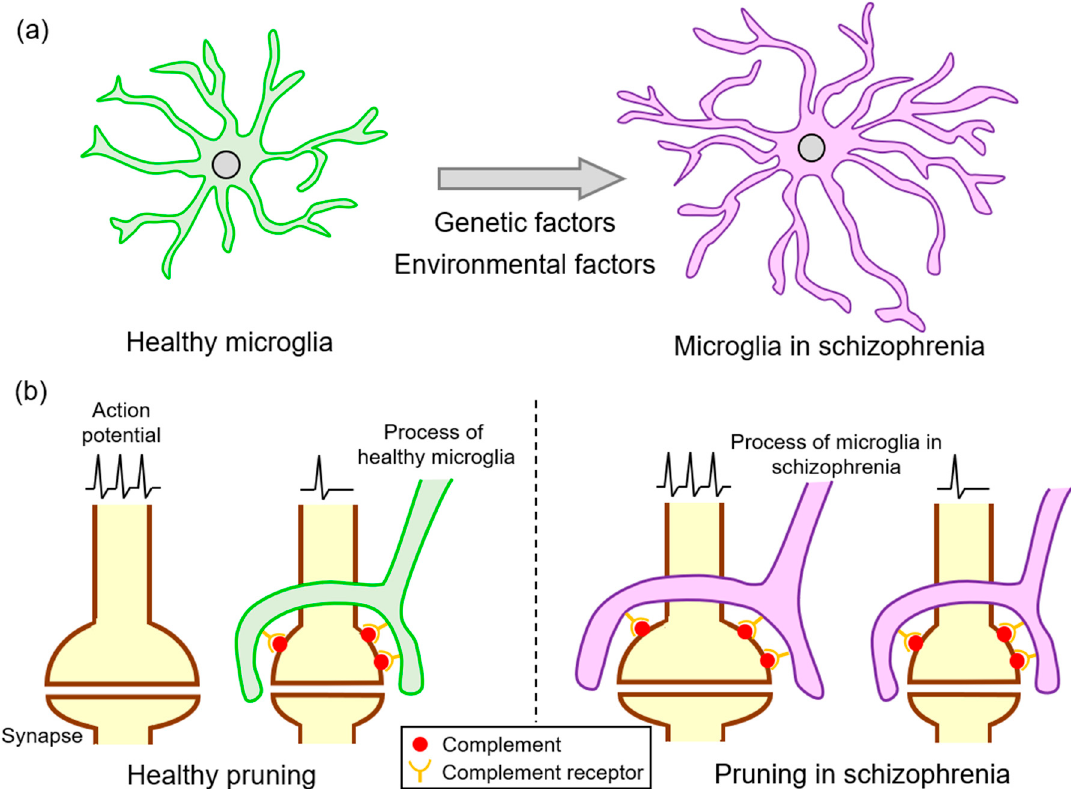
Figure 2. The microglial synaptic pruning in schizophrenia. ( a ) Microglia exhibit hyper-ramified morphology in schizophrenia due to genetic and environmental factors. ( b ) Healthy microglia eliminate complement-tagged synapses with lower activity. In schizophrenia, hyper-ramified microglia prune healthy synapses by the excessive activation of comple- ments.